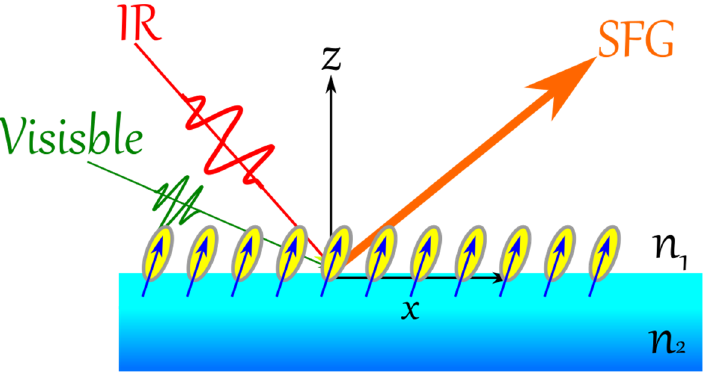
Figure 7. Schematic representation for the VSFG setup, in which SFG signal is produced at the